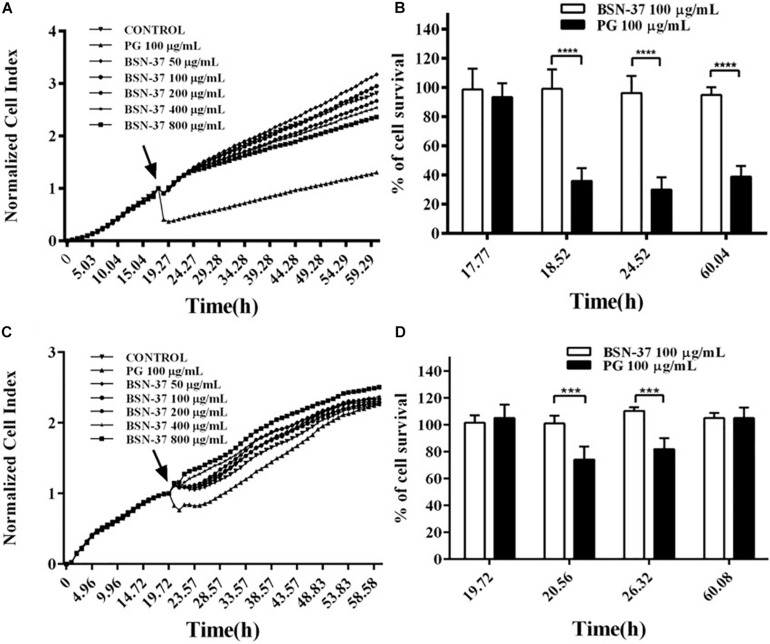
Real-time measurement of the cytotoxicity of BSN-37 and pexiganan against IPEC-J2 cells and Vero cells and the survival rates of IPEC-J2 cells and Vero cells incubated with 100 μg/ml BSN-37 and 100 μg/ml pexiganan for different times. (A,C) Real-time monitoring of the cytotoxicity of IPEC-J2 cells and Vero cells, respectively, treated with BSN-37 at a different concentrations (50, 100, 200, 400, and 800 μg/ml) and pexiganan at the concentration of 100 μg/ml for 60 h using the xCELLigence system. The black arrows indicate the time points of adding the peptides. The cells without antimicrobial peptide were used as control. (B,D) parallel comparisons of the survival rates of IPEC-J2 cells and Vero cells, respectively, treated with 100 μg/ml BSN-37 and 100 μg/ml pexiganan at specific four time points. Error bars represent means ± SEM, n = 3. *** and **** represents very significance and extremely significance, respectively. (p < 0.001 and p < 0.0001 by Two-way ANOVA).